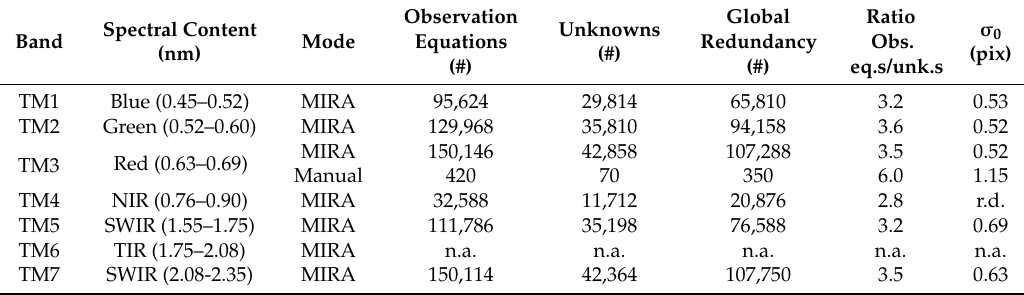
Figure 6. Connectivity graph obtained from Band TM4 (on the left) of the ‘Multan’ dataset, showing the separation of the entire blocks in two parts. This graph is compared to the one obtained from band TM3 (on the right), which corresponds to the best connections. In these graphs, circles represent the images while lines indicate the availability of sufficient TPs to connect each pair. Table 5. Summary of global registration results after BBA in different spectral bands (n.a.: not applicable; r.d.: rank deficiency).